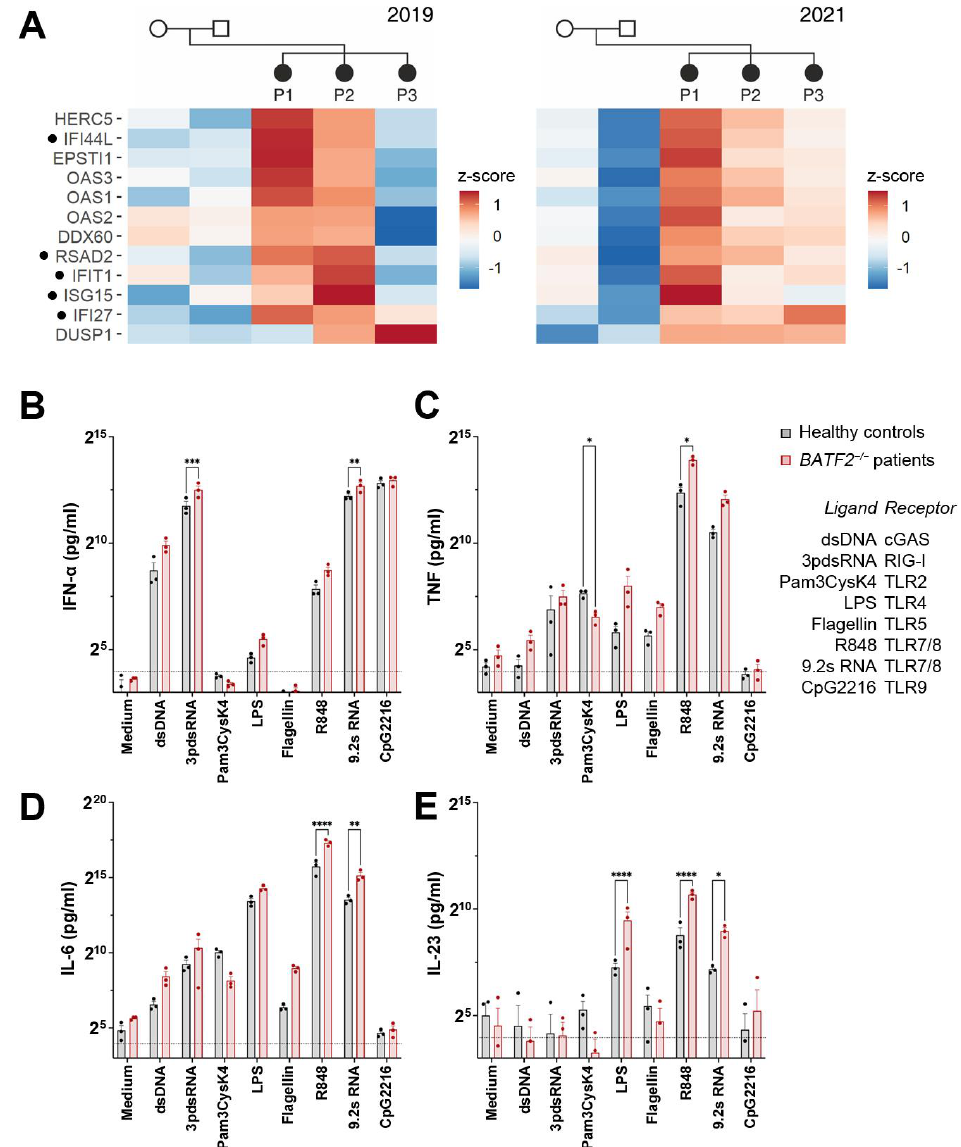
Figure 2. Loss of BATF2 causes elevated expression of interferon-stimulated genes in patients. ( A ) Dif- ferentially upregulated genes in the patients’ whole-blood mRNA as compared to their unaffected parents by 3 (cid:48) RNA sequencing. Heatmaps of z-scores of normalized gene counts are shown from two different time points (years 2019 and 2021). Genes are shown that were significantly upregulated (FDR < 0.05) in patients at least at one of the time points and always displayed higher values in at least two of the patients compared to the parents. Genes associated with type I interferonopathies [28] are indicated by dots. P1–3, patients. NB: patient 3 has severe leukopenia, which might affect the detected expression of interferon-stimulated genes. ( B – E ) In-vitro TLR7/8 stimulation of periph- eral blood mononuclear cells (PBMCs) obtained from the BATF2 p.Gln19* patients demonstrate upregulated cytokine release. PBMCs were stimulated with double-stranded DNA (ligand of cGAS), double-stranded RNA (ligand of RIG-I), 200 pg/mL Pam3CysK4 (ligand of TLR2), 100 pg/mL LPS (ligand of TLR4), flagellin (ligand of TLR5), 10 µ M R848 or 9.2 s RNA (ligand of TLR7/8), or CpG DNA (ligand of TLR9). The corresponding receptors are indicated in the figure legend. Cellular supernatants were harvested for IFN- α , TNF, IL-6, and IL-23 ELISA. Arithmetic means ± SEM from three independent experiments is presented. Statistical significance was analyzed via a two-way ANOVA with Šid á k’s correction. *, p < 0.05; **, p < 0.01; ***, p < 0.005; ****, p <